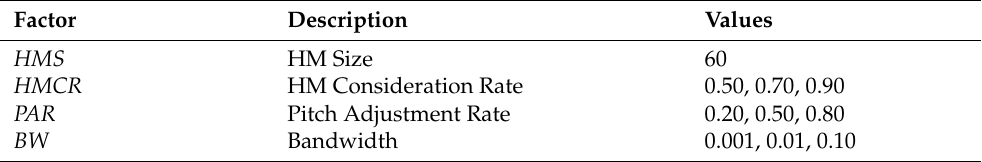
Table 5. Experimental plan for the calibration of the hybrid Harmony Search.